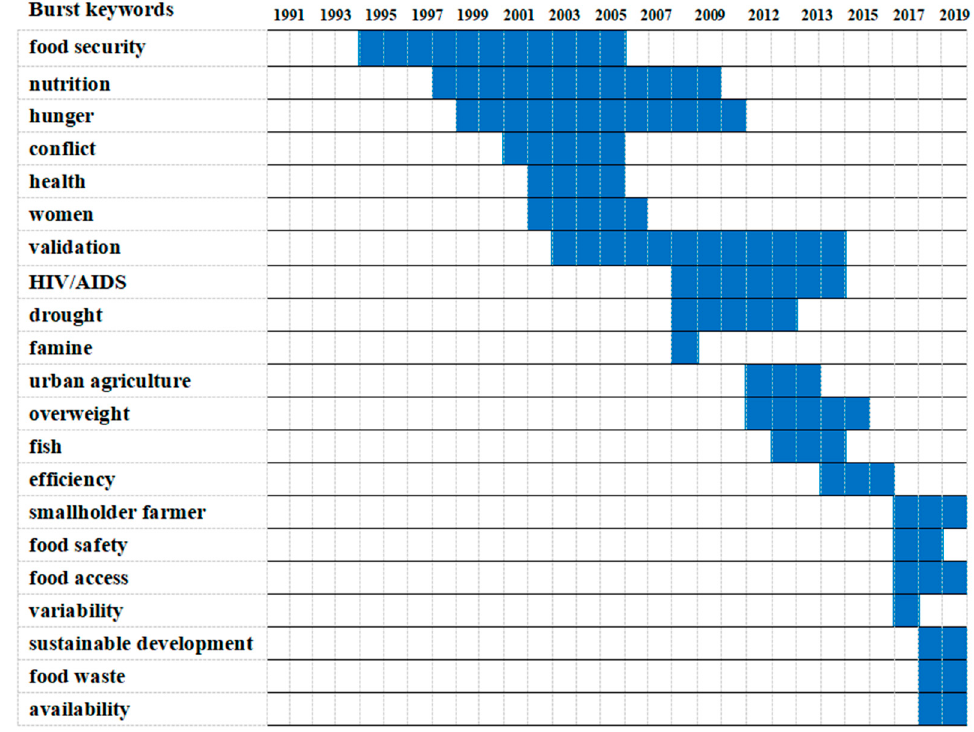
Figure 10. Burst keywords for food security.